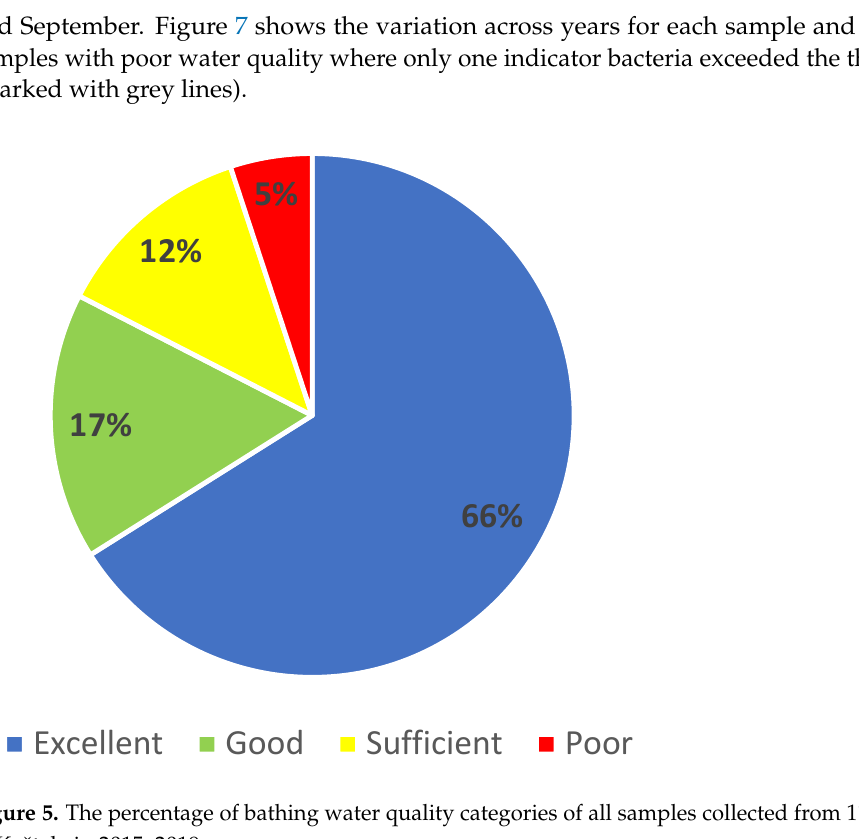
Figure 5. The percentage of bathing water quality categories of all samples collected from 11 beaches in Kaštela in 2015–2019.